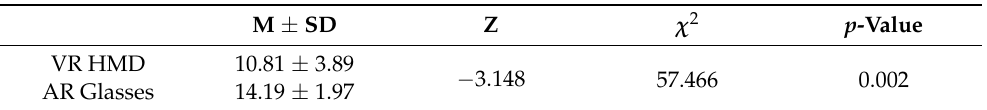
Table 6. Comparison of the blink rate in the VR HMD environment and AR glasses environment ( n = 21).